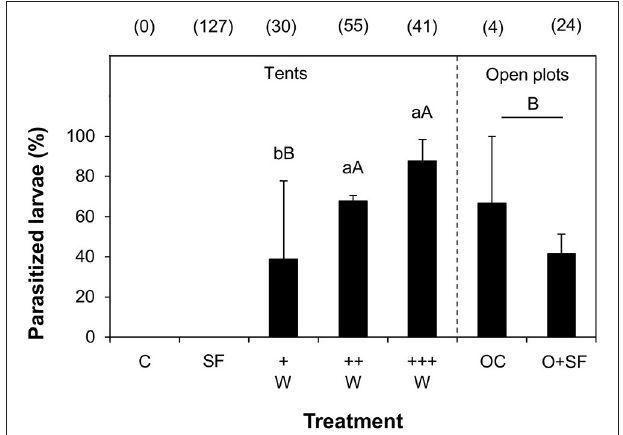
FIGURE 2 | Parasitism of Spodoptera frugiperda larvae. Average percentage of parasitized larvae ( + SE) on teosinte plants. The larvae came from tents that were not infested with herbivores (treatment C) or that were infested with larvae in the absence (SF) or in the presence of different numbers of Campoletis sonorensis parasitoid wasps ( + W, ++ W, + + + W), or from uncovered plots (OC, O + SF). The total number of larvae retrieved from each plot is given in brackets (total number of collected larvae minus the number of larvae that escaped or died for unknown reasons). Different letters indicate statistically significant differences (GLM, P < 0.05). Lowercase letters represent significant differences between plots in tents in which different wasp numbers were released. Uppercase letters represent significant differences between all treatments where wasps were present; both open plots were combined as a single “open plot” treatment for statistical